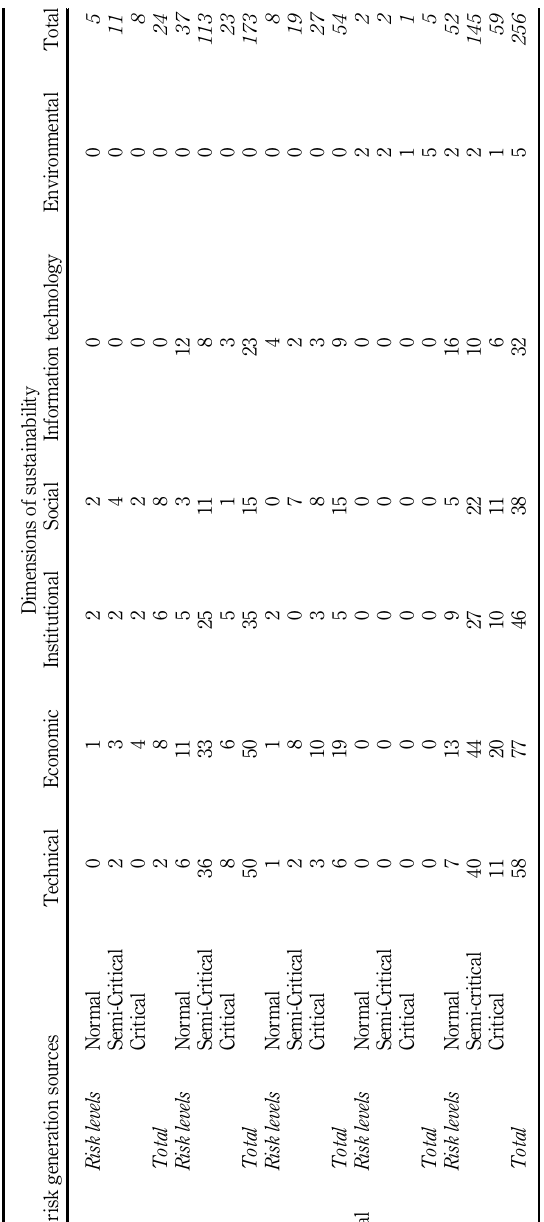
Table 3. The status of the